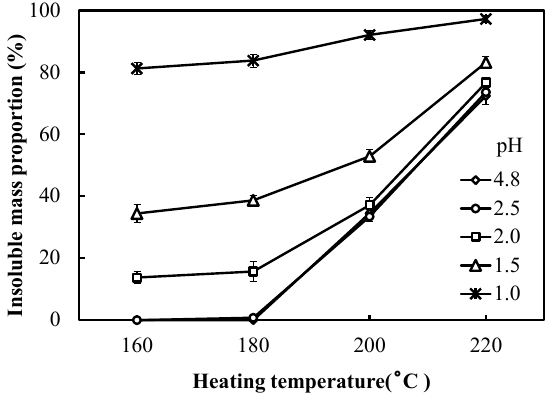
Figure 3. Insoluble mass proportion of the adhesives with different pH values and heated for 10 min.